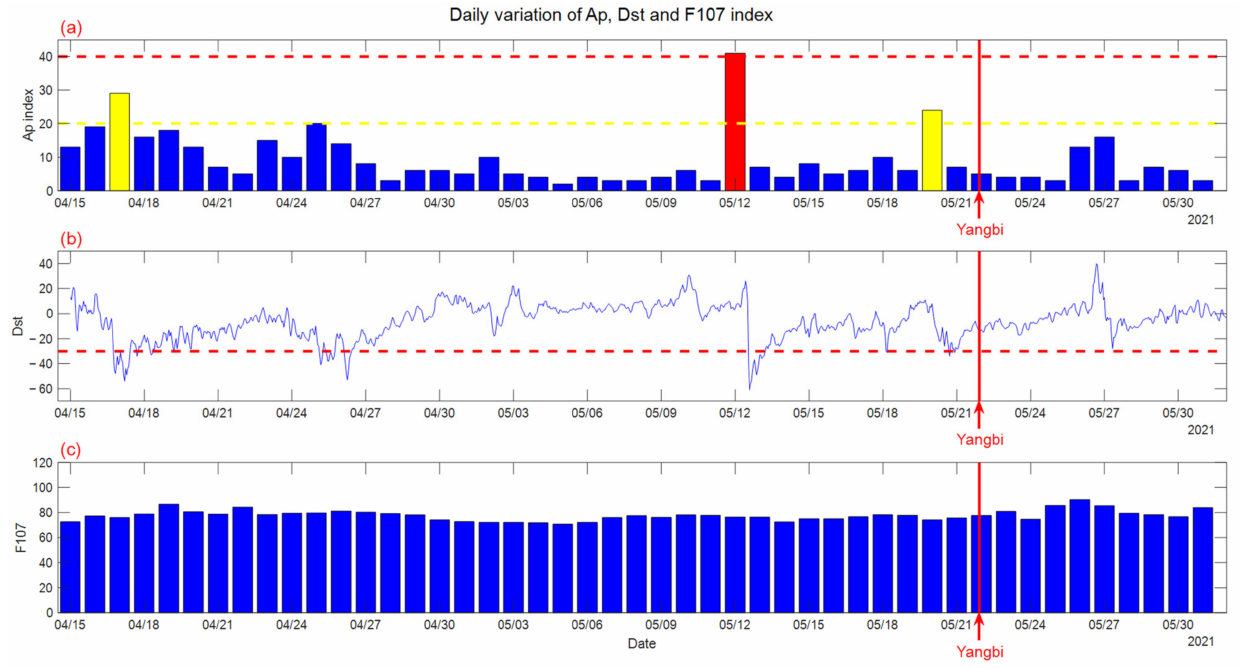
Figure 2. Daily variation of Ap, Dst and F107 index. ( a ) Ap index, data over 20 are shown in yellow and over 40 in red; ( b ) Dst index, red-dashed lines indicate the boundaries; ( c ) F107 index. In each figure, red lines indicate the date of the first earthquake (Yangbi Ms6.4 earthquake, at BJT 21:48 on 21